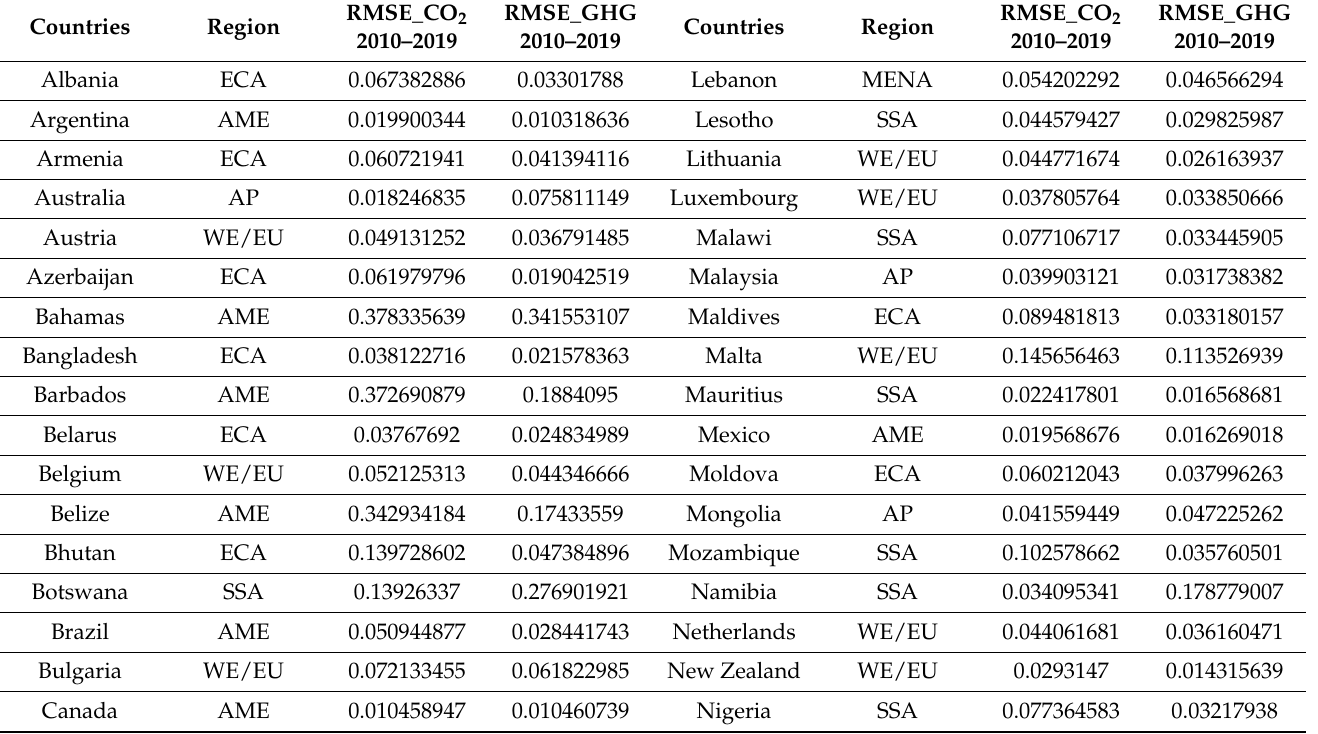
Table A1. The Root Mean Square Errors of CO 2 and GHG emissions for the 95 countries of the sample (period from 2010 to